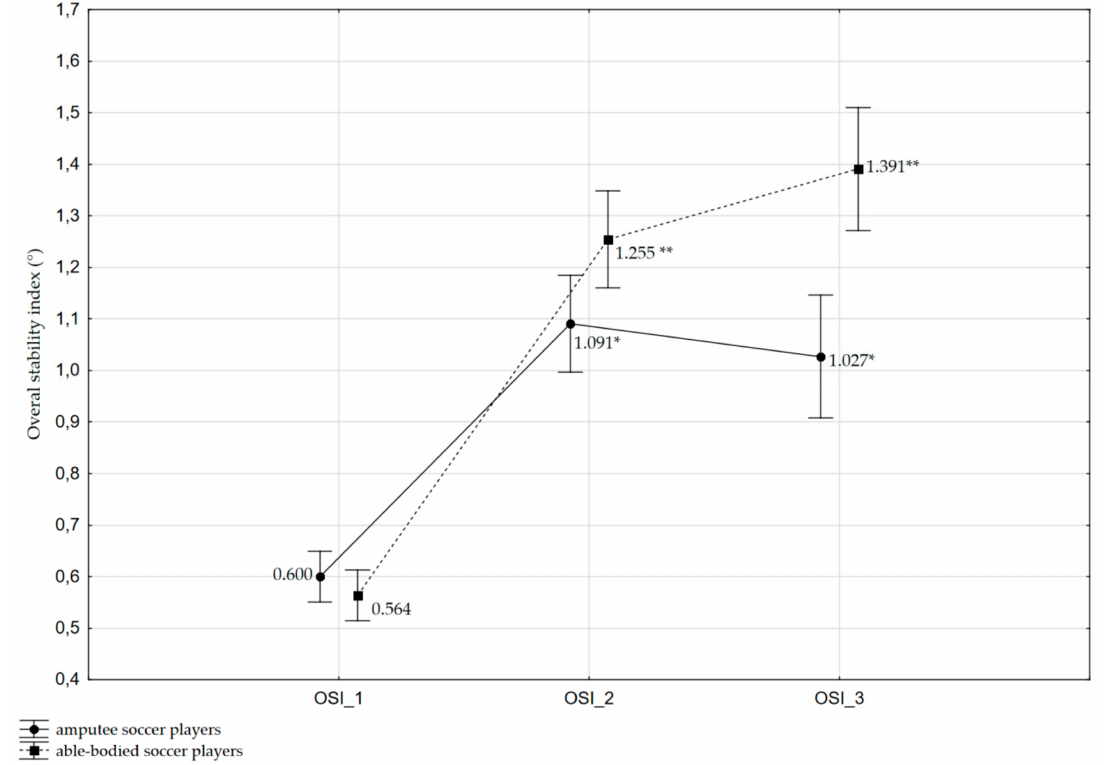
Figure 1. Interaction between Group and Test repetitions for overall stability index (OSI) (F (2,40) = 3.336, p < 0.05, η p 2 = 0.143). Subsequent values of OSI in amputee soccer players and able-bodied soccer players are presented as means ± standard error. Significant intragroup di ff erences between postural control tests (OSI_1 vs. OSI_2 and OSI_1 vs. OSI_3) are denoted with * ( p < 0.01) and ** ( p <